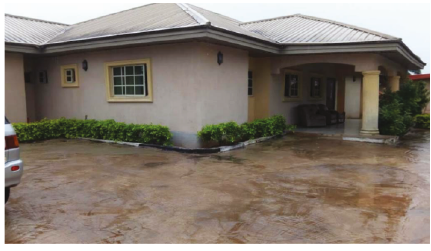
Figure 1: House side view.